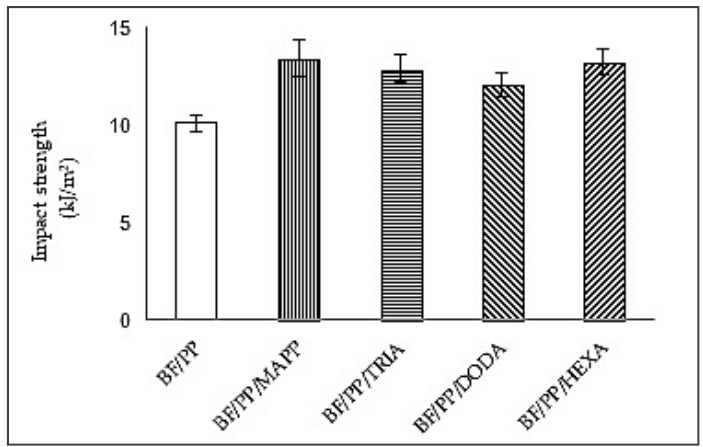
Figure 5. Results of the impact strength test of the composites without CA and with CA.